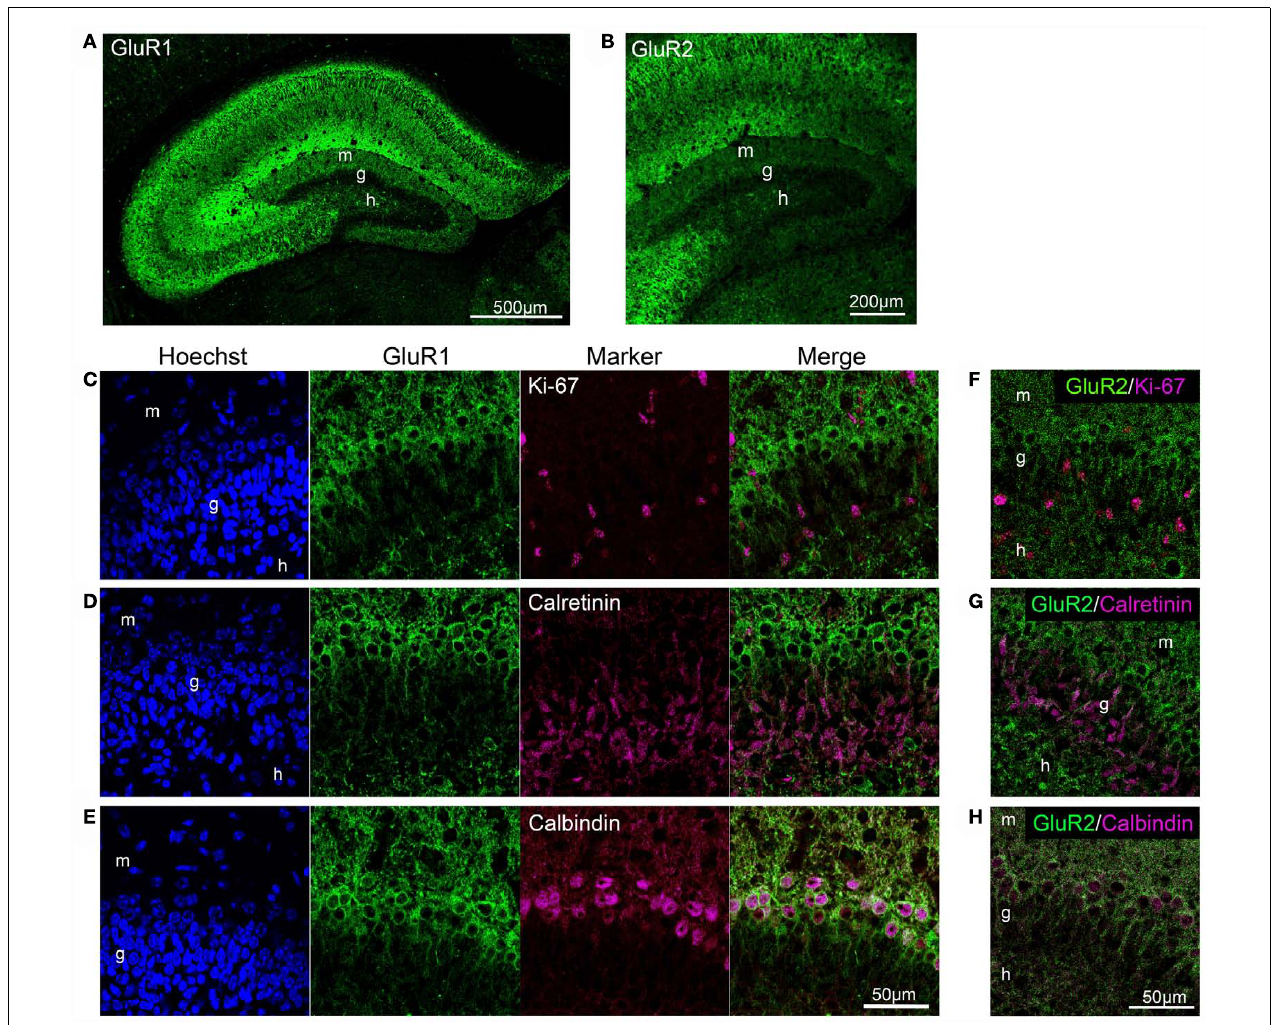
immature granule cells (D) , or calbindin, mature granule cells (E) in the dentate gyrus. (F–H) Co-labeling of GluR2 with Ki-67 (F) , calretinin (G) , and calbindin (H) . g, Granule cell layer; h, hilus; m, molecular